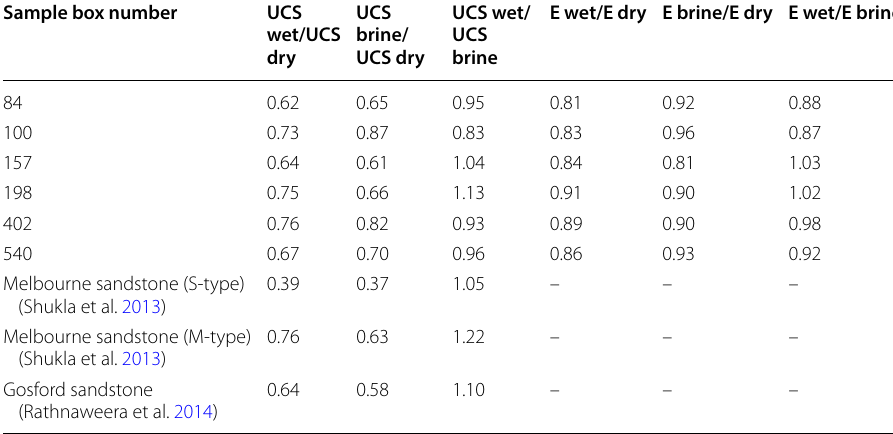
The UCS of the brine‑saturated samples taken from Shukla et al. (2013) and Rathnaweera et al. (2014) correspond to the salt concentration closest to that tested herein (NaCl 10%) UCS uniaxial compressive strength, E static elastic